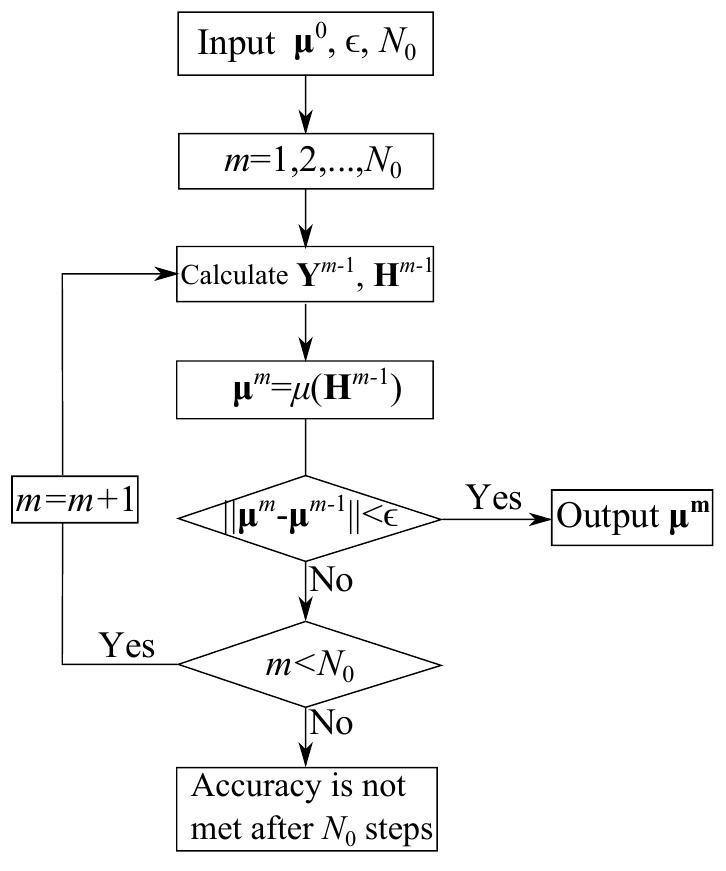
Figure 8. Iteration